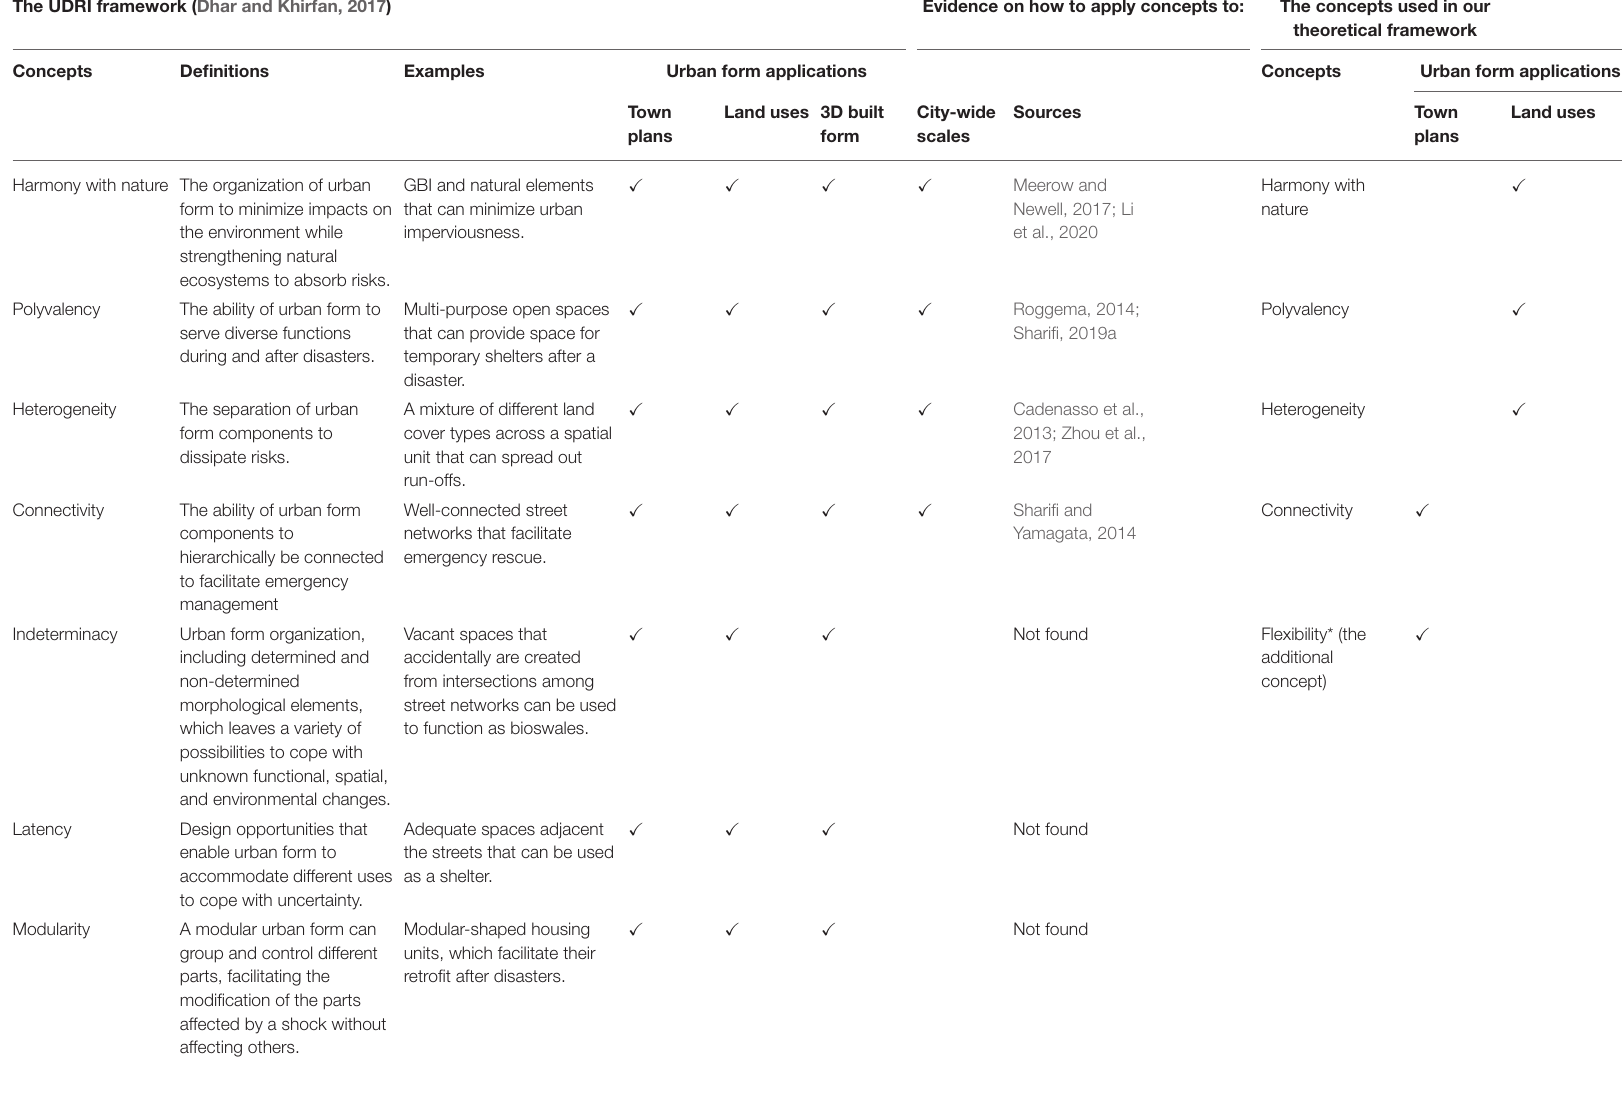
TABLE 1 | The UDRI framework adapted from Dhar and Khirfan (2017, p. 83–84) and the concepts from this framework that this study uses. The UDRI framework (Dhar and Khirfan,